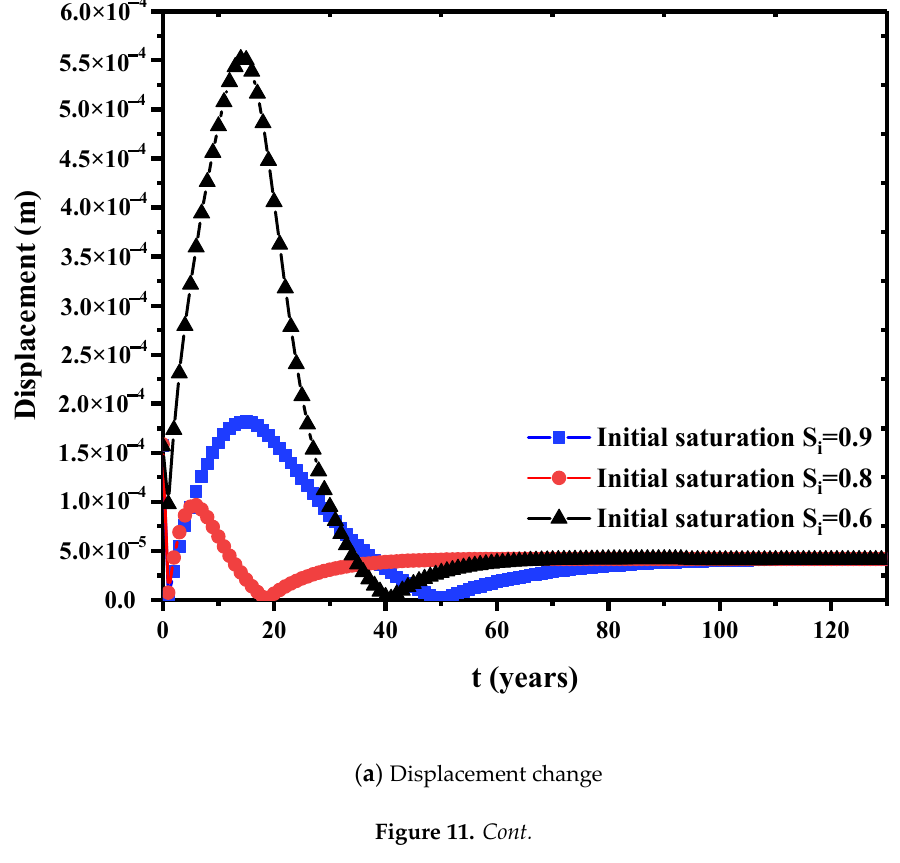
Figure 10. Variation of cumulative pollutant emissions at different initial saturations.